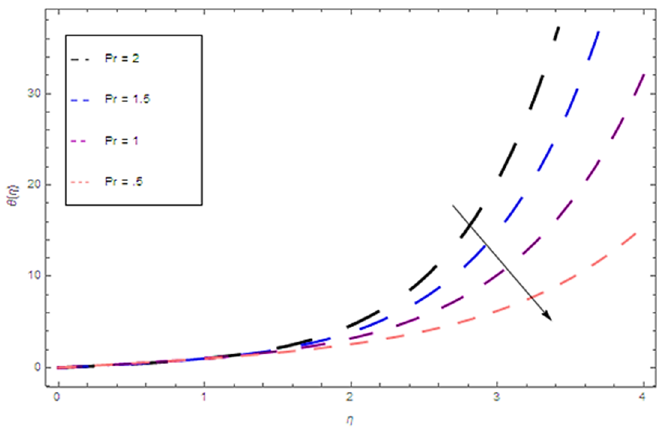
Figure 10. Impact of Pr on Figure 10. Impact of Pr on θ ( η ) for M = 0.3, Ω = 0.4, S = 0.5, Nt = 0.8, Sc = 0.7, Nb = 0.6. Figure 10. Impact of Pr on